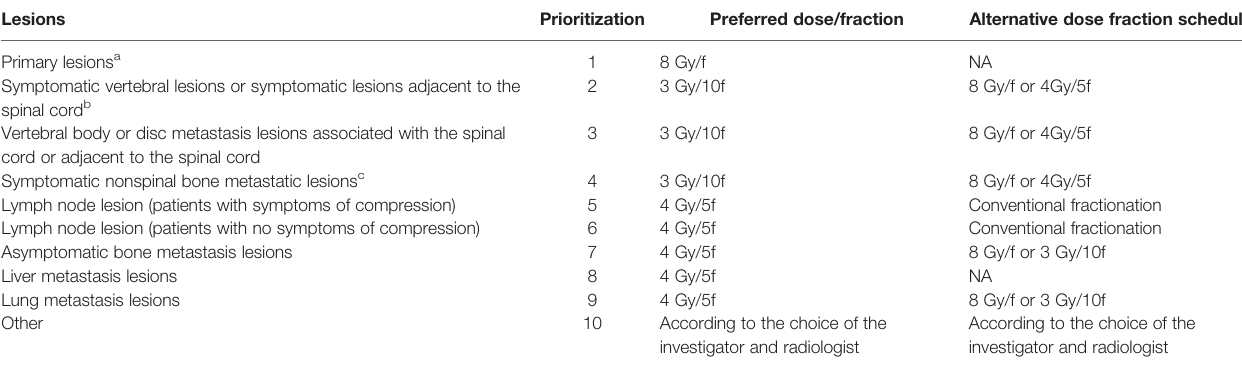
TABLE 3 | The priority order for the selection of disease sites.